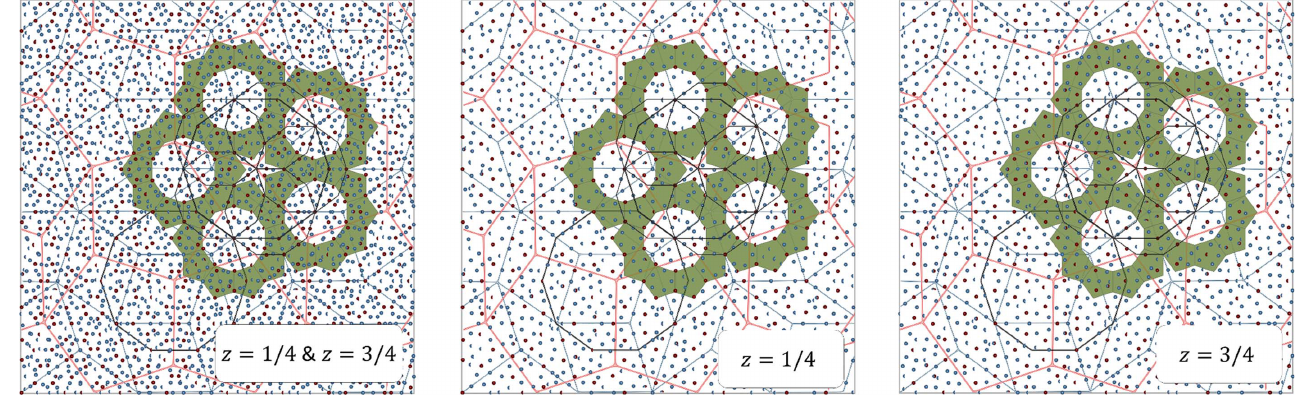
Figure 8 100 (cid:7) 100 A˚ sections through the refined structure of decagonite. The RPTand PPTare plotted over the structure for guidance. Two exemplary Hiraga clusters with the subdivision into Deloudi clusters are additionally presented. The formation of pentagonal bipyramids is marked with green